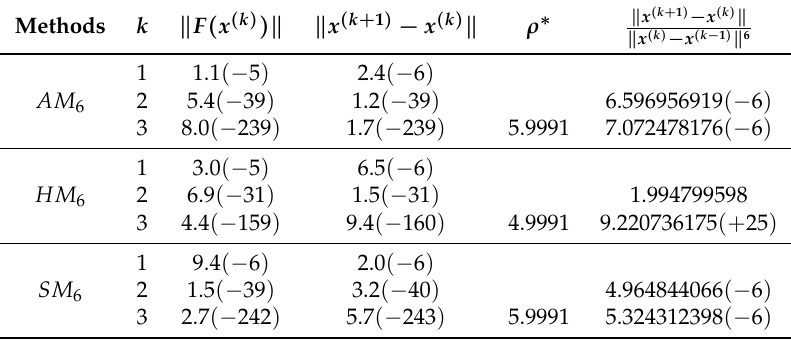
Table 2. Comparison of methods on Hammerstein integral equation in Example